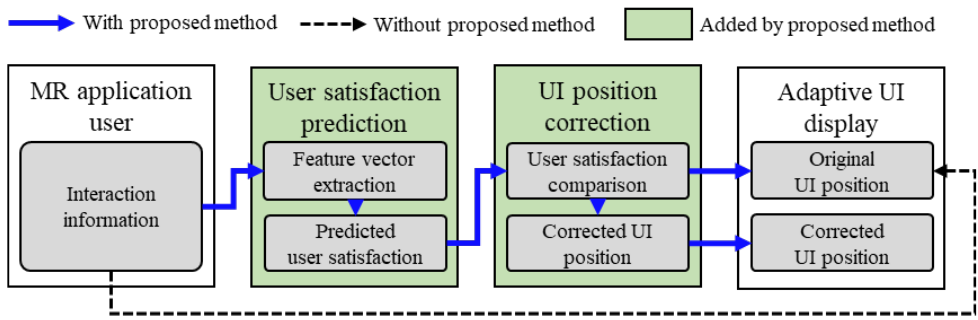
Figure 12. Procedure applying the proposed adaptive UI. The black dashed arrow in Figure 12 is an example of a case without the proposed method, and the interaction information of the MR-application user is directly input to the UI-display part. On the other hand, blue arrow is an example of the proposed-method case, and MR-user-interaction information is input to the user-satisfaction-prediction part.